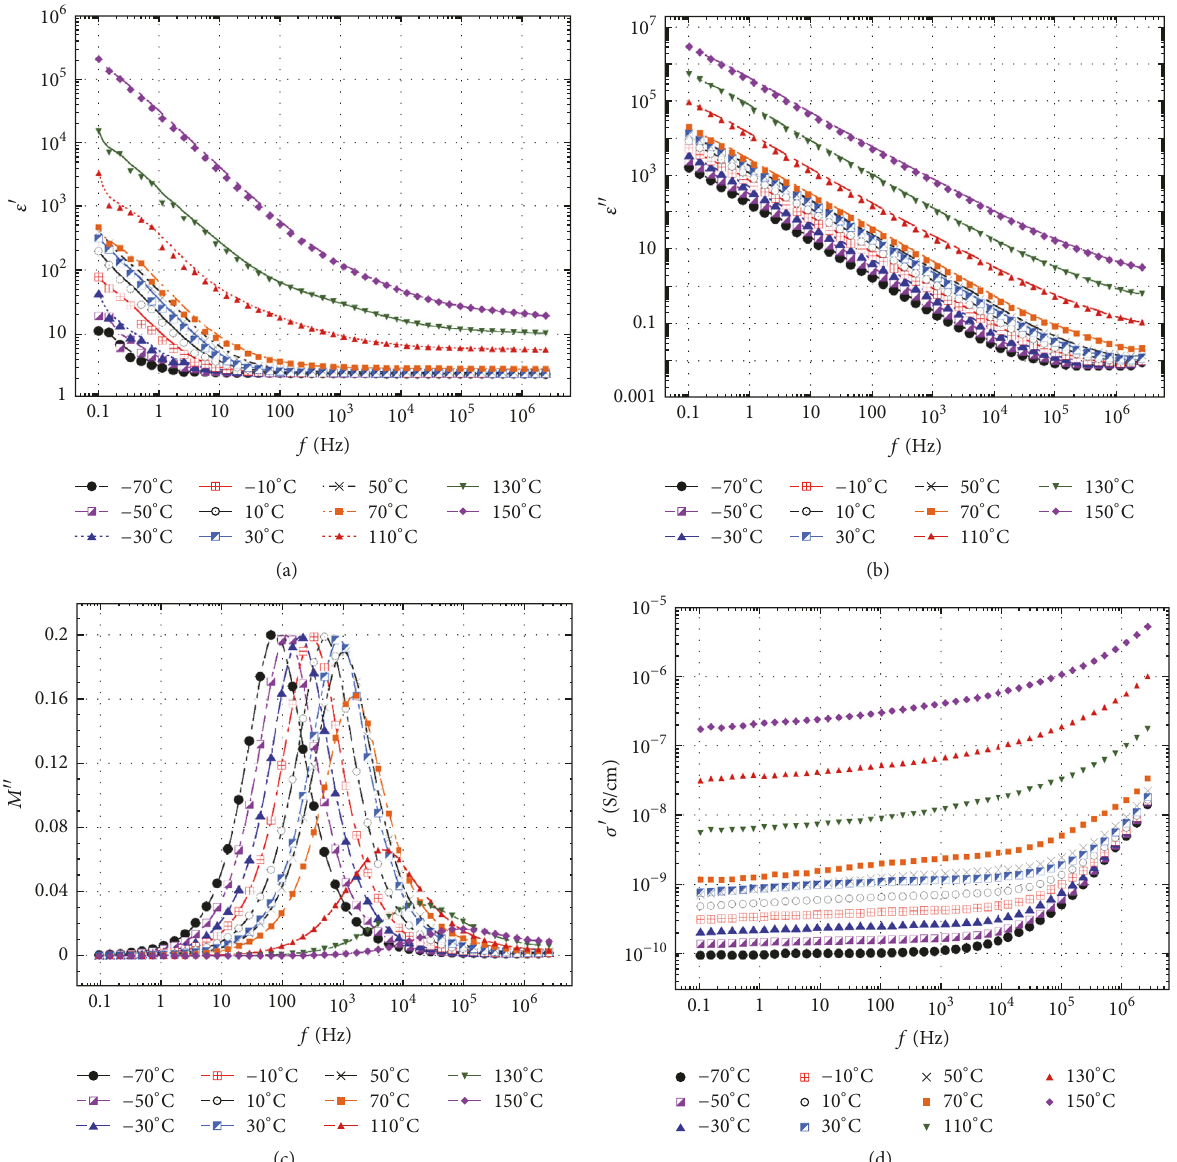
Figure 1: Dielectric permittivity storage (a), loss (b), electrical modulus (c), and AC conductivity (d) for the PANI-PS-0.2 CSA sample at different